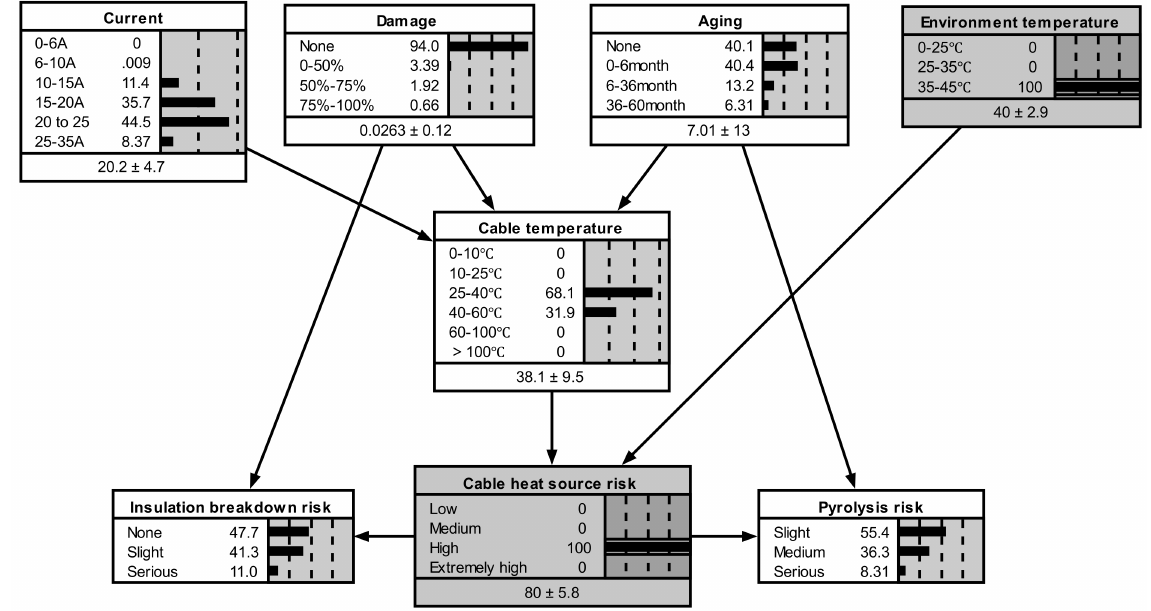
Figure 9. Bayesian network reasoning